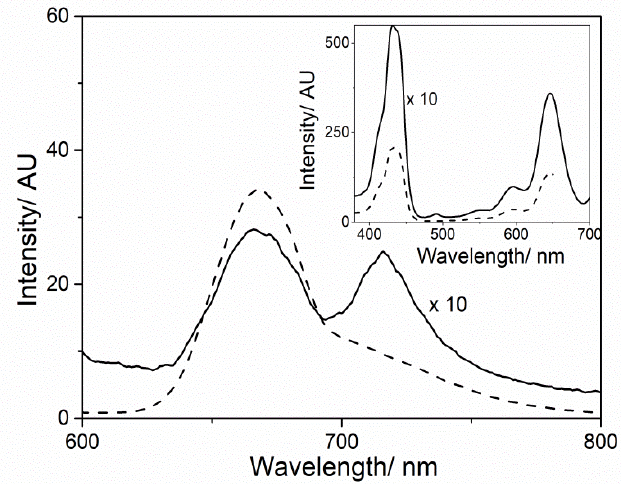
Figure 5. Fluorescence emission spectra of MWCNT-EPA / TPPS J-aggregates system 1 day after mixing (dashed and solid lines recorded at λ exc = 455 and 493 nm, respectively) and, in the inset, the corresponding excitation spectra (dashed and solid lines recorded at λ em = 669 and 717 nm, respectively). Experimental conditions: [TPPS] = 5 µ M; MWCNT-EPA = 0.02 mg / mL; 10 mM citrate bu ff er at pH 2.4; PL protocol; T = 298 K.